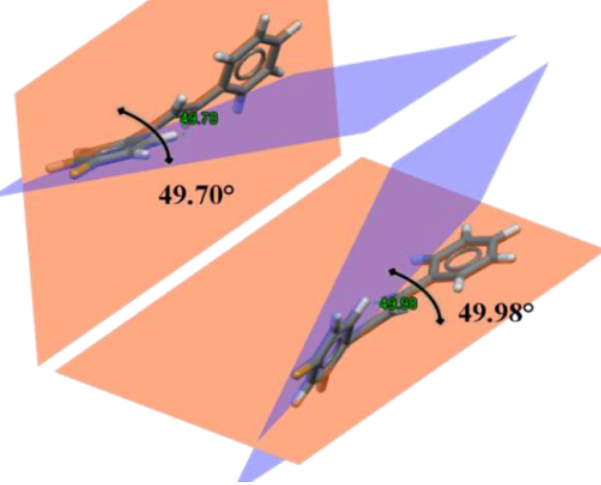
Figure 10. Illustration of the angles between rings for BBP.